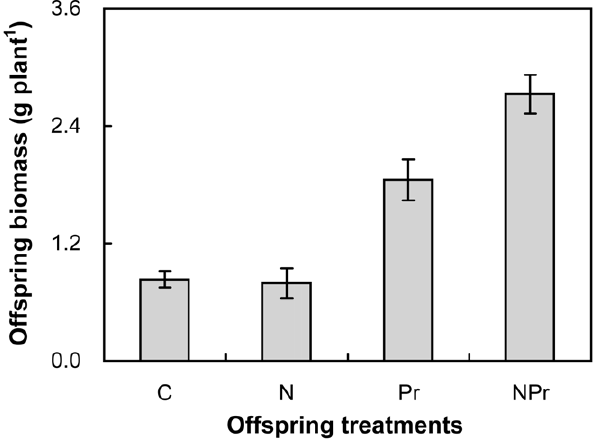
Figure 5. Effects of maternal-treatments on seedling biomass (g). The seedlings were germinated from the seeds collected from the plots with 4 maternal treatments in the field and grown under the same offspring environment in the greenhouse. Data are mean 6 SE (n=7). See Figure 1 for abbreviations.